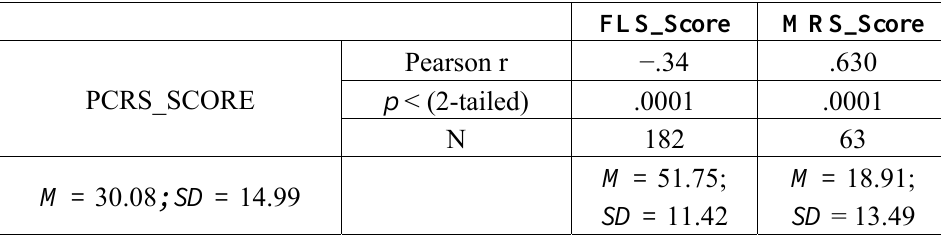
Table 2. Correlations of PCRSS with FLS and